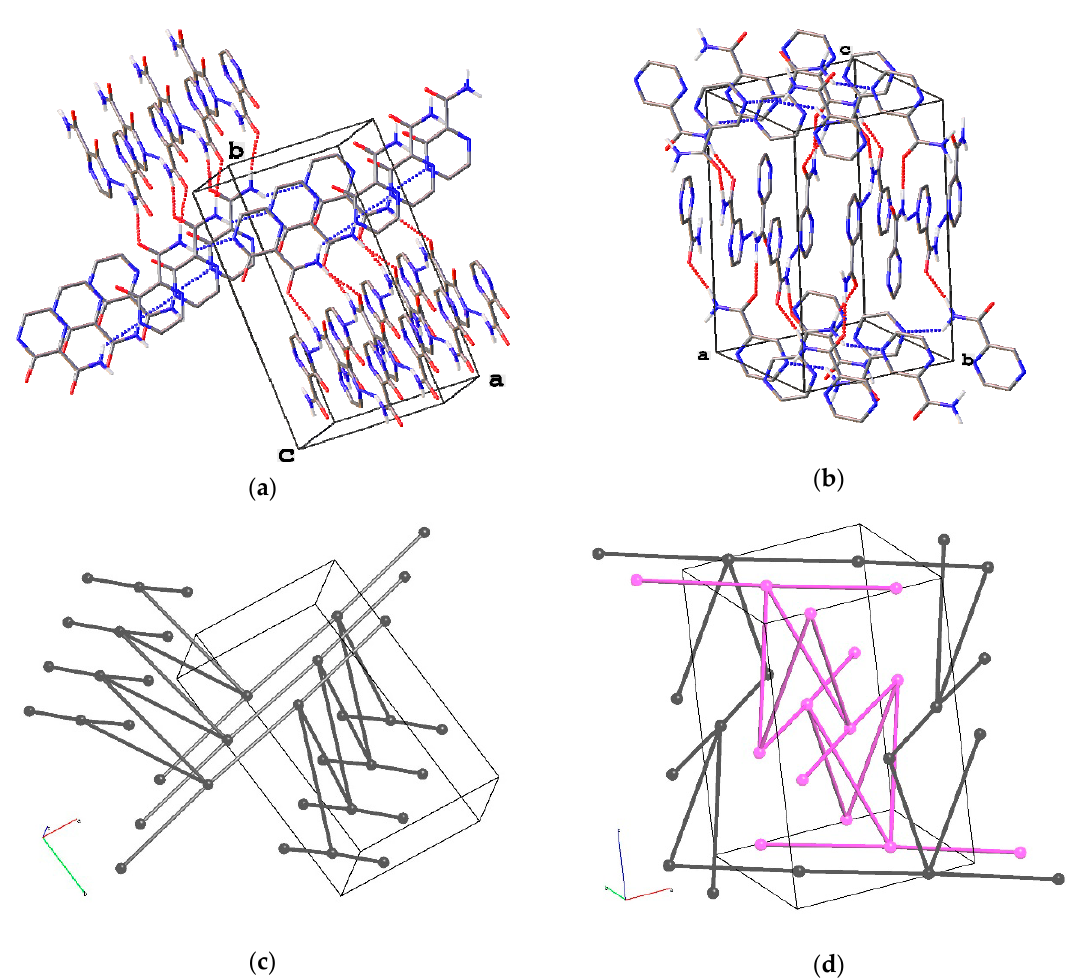
Figure 6. Fragment of H-bonded networks in ( a ) orthorhombic and ( b ) tetragonal polymorphs of favipiravir and their underlying nets (( c ) zst and ( d ) 4/4/t39, respectively). H(C) and F atoms are omitted. Two interpenetrated networks are depicted with black and fuchsia.